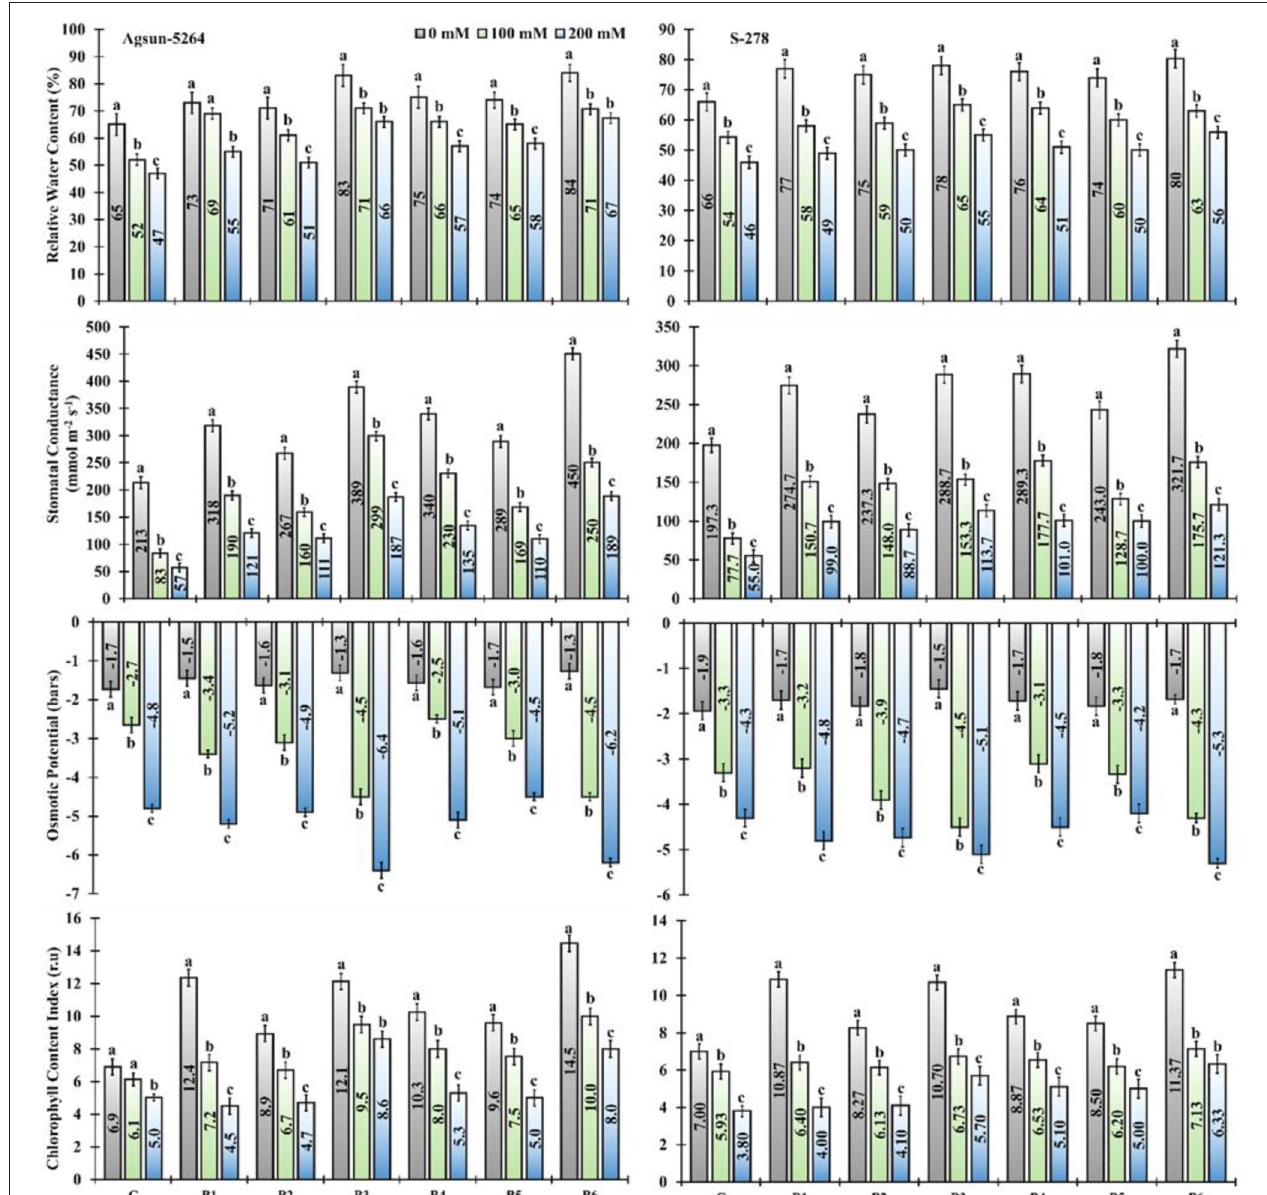
FIGURE 2 | Effect of halophilic microbial strains on the relative water content (RWC), stomatal conductance (S.C), osmotic potential (O.P), and chlorophyll content index (CCI) of sunflower cultivars under salinity stress. Vertical line on the bar represents mean standard error (S.E). Similar alphabet shows non-significant difference at p ≤ 0.05 ( Bonferroni post-hoc test ) between treatments. Symbols on the horizontal axis represents plants: C = Without Bacillus species, B1 = Bacillus cereus strain KUB-15 , B2 = Bacillus cereus strain KUB-27 , B3 = Bacillus licheniformis strain AAB9 , B4 = KUB-15 + KUB-27 , B5 = KUB-27 + AAB9 and B6 = KUB-15 + AAB9 . Legends demonstrate that 0mM = Control plants without salinity stress, 100mM = Plants treated with 100mM NaCl, and 200mM = Plants treated with 200mM